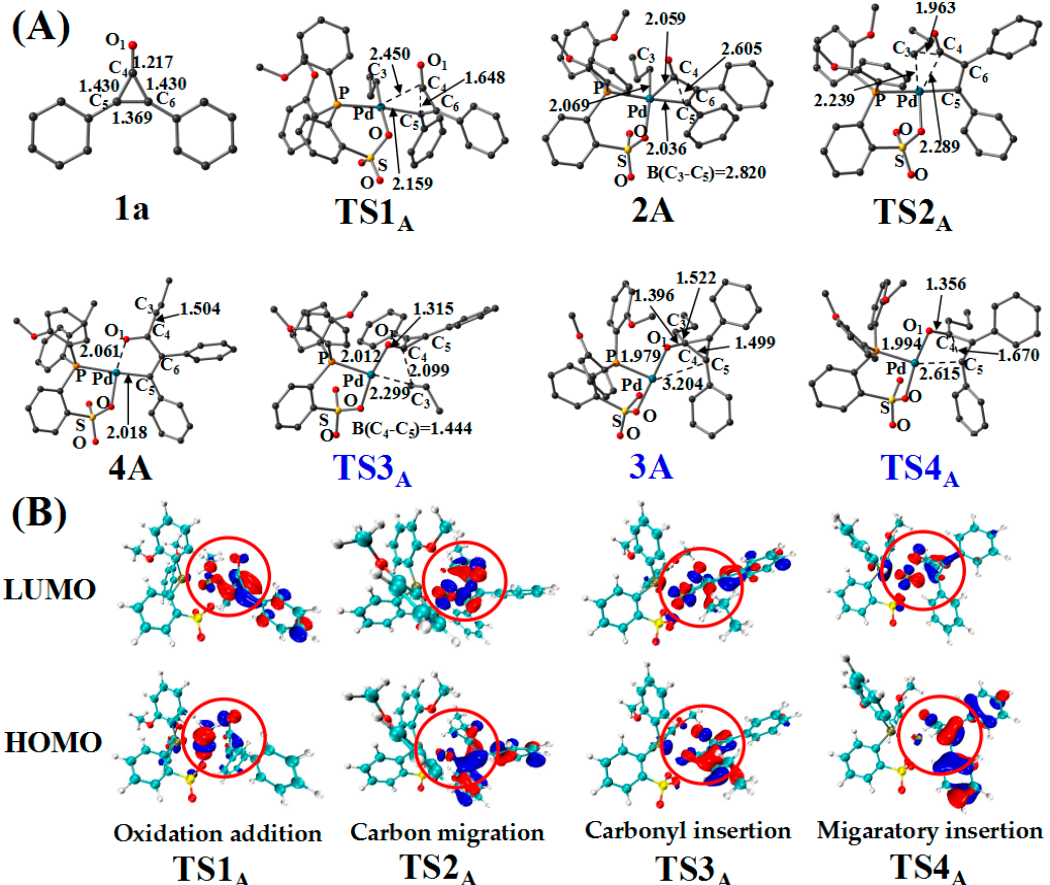
Figure 4. ( A ) Optimized structures in the cyclopropenone reaction pathway shown in Figure 3, Path A 1a (black) and Path B 1a (blue), the key length is in angstroms. For clarity, the hydrogen atom is omitted. ( B ) The frontier orbital (HOMO and LUMO) of the transition states.